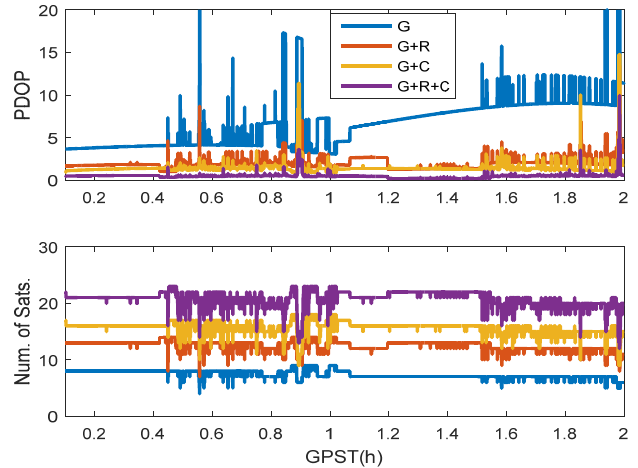
Figure 2. Numbers of satellites and positional dilution of precision (PDOP) values of multi-constellation PPP. BDS: BeiDou Navigation Satellite System; GLONASS: Globalnaya Navigatsionnaya Sputnikovaya Sistema; GPS: global positioning system; G: GPS only; G + R: GPS/GLONASS combination; G + C: GPS/BDS combination; G + R + C: GPS/GLONASS/BDS combination. ISPRS Int. J. Geo-Inf. 2017 , 6 , 6